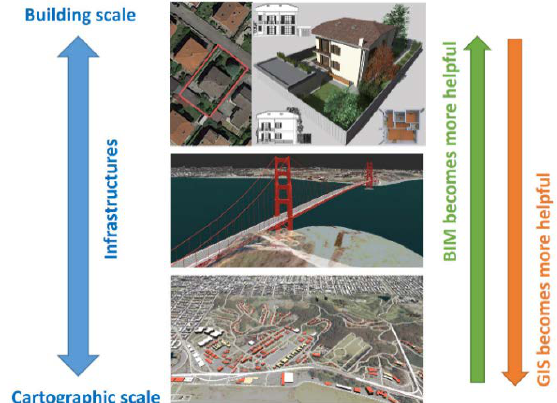
Figure 1. BIM and GIS can be intended as complementary solutions in several projects. Specific tools are available to solve for different aspects of practical